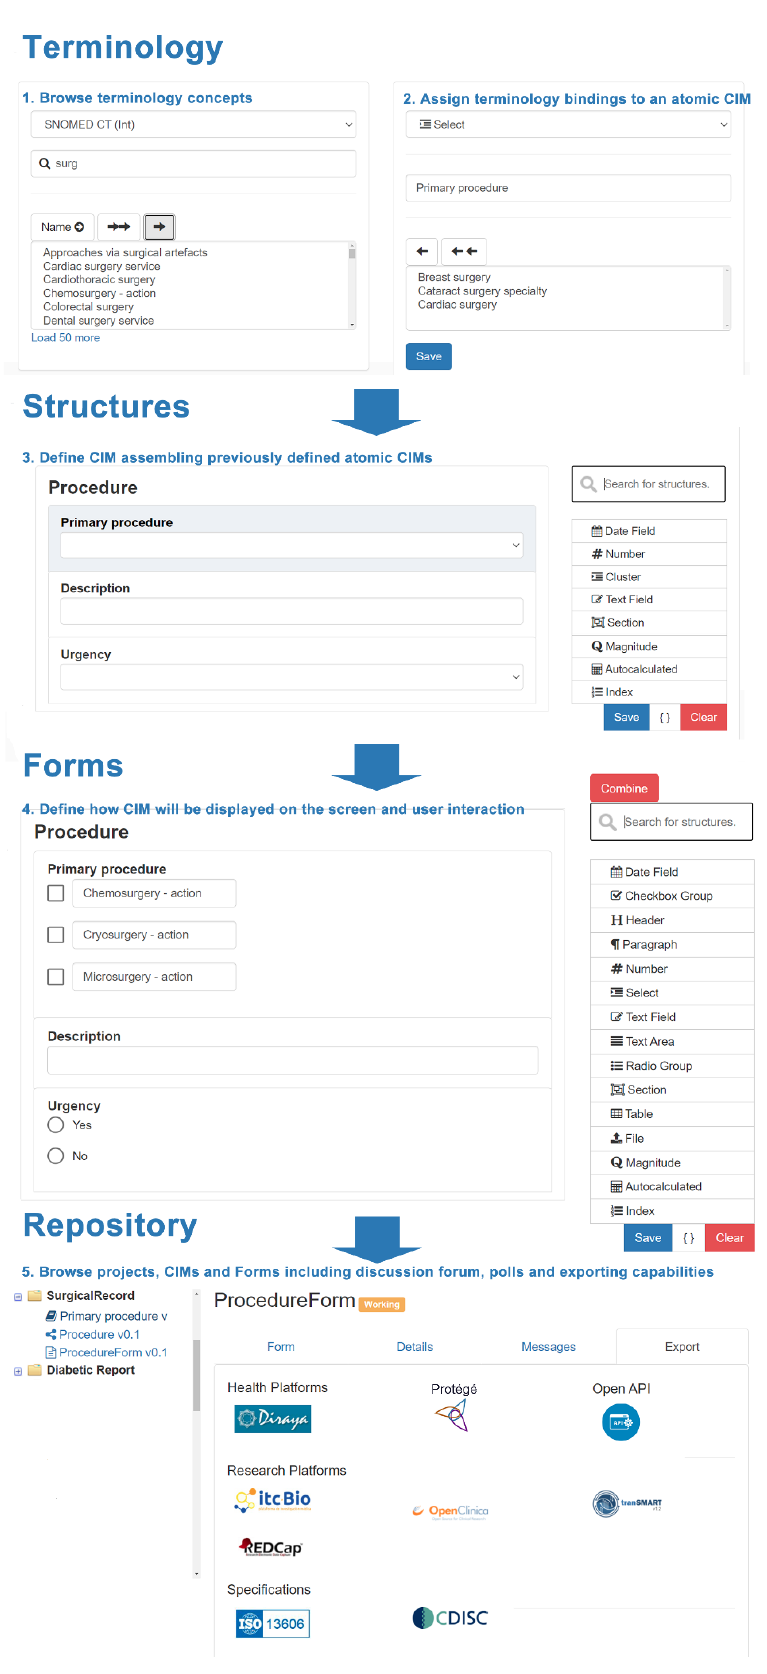
Figure 4. Details for the clinical information modeling process to define an implementable form.